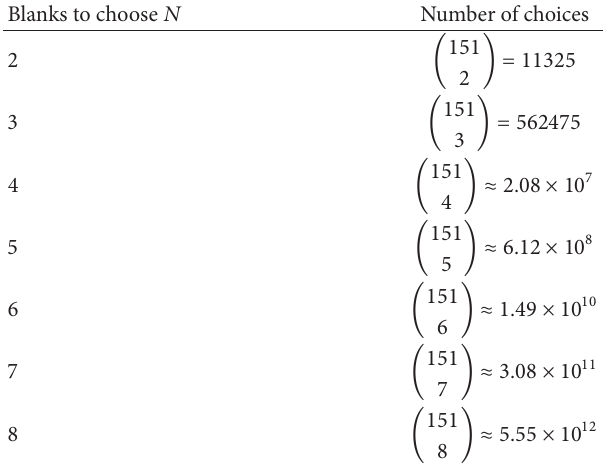
Table 3: Problem size as a function of